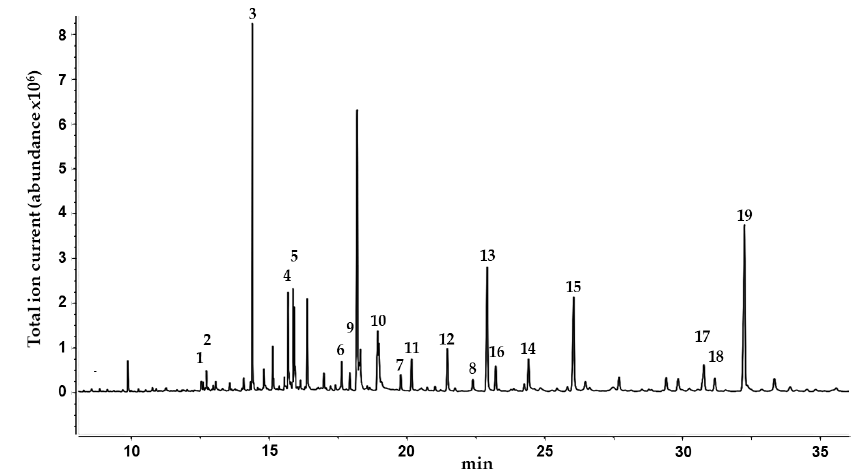
Figure 2. GC-MS chromatogram of the n -hexane extract of the leaves of C. collinum after silylation with BSTFA. Peaks were identified with the NIST08 database. Table 3. Summary of the compounds identified from the n -hexane extract of the leaves of C. collinum after silylation with N , O -bistrifluoroacetamide (BSTFA) by NIST08 database. Substances in bold were confirmed by spiking experiments with reference compounds. Number labels correspond to the compounds listed in Figure 2.